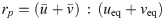
Effects of directed migration on population densities and frequency of cooperation as compared to unstructured populations.In the absence of directed migration (undirected migration only) homogeneous coexistence results with densities Q = (ueq, veq). The two panels depict the ratio of the average spatial population density to the population density in unstructured populations, rp=(u¯+v¯):(ueq+veq) (black solid line), and the ratio of the average cooperator frequency to their frequency in unstructured populations, rc=u¯/(u¯+v¯):ueq/(ueq+veq) (green solid line) for (A) cooperator aggregation, AC, and (B) spreading defectors, RD. (A) increasing AC gives rise to four dynamical regimes: (i) homogeneity maintained, (ii) formation of smooth patterns, (iii) discontinuities emerge, and (iv) population expansion prevented. (B) increasing RD only results in two regimes: (i) homogeneity (ii) formation of smooth patterns. In order to facilitate comparisons of regions (i) and (ii) across panels the large effects of discontinuities in (iii) and (iv) refer to the scale on the right of panel (A). In either case, heterogeneous distributions increase (average) population densities and cooperator frequencies. In (A), once discontinuities develop, populations consist exclusively of cooperators. The decrease in rp for large AC relates to the fact that populations are unable to expand and hence the ratio depends on the initial configuration. In contrast, rc remains unaffected because defectors are absent and cooperators are at the maximum frequency. Parameters as in Fig 3.